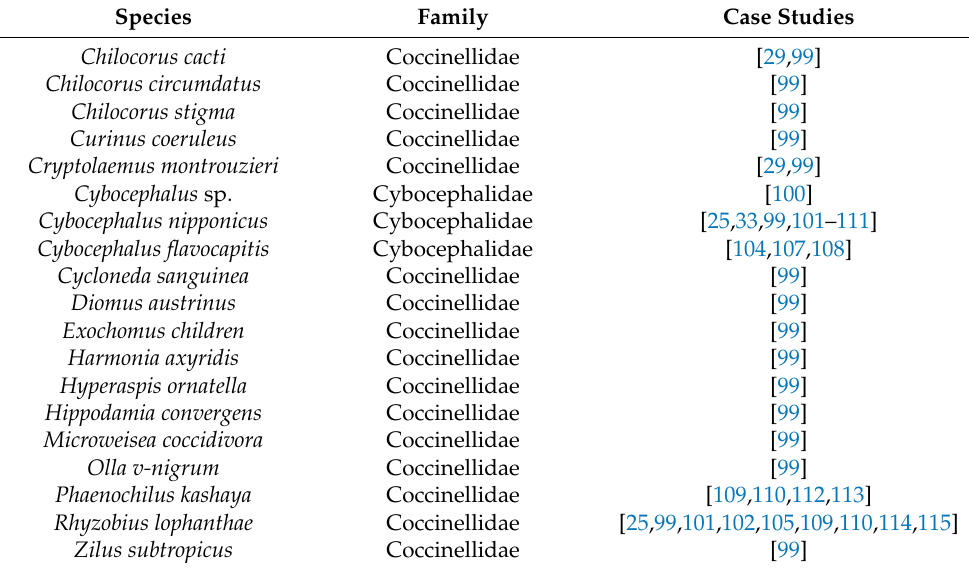
Table 3. A list of predators known to feed on Aulacaspis yasumatsui .